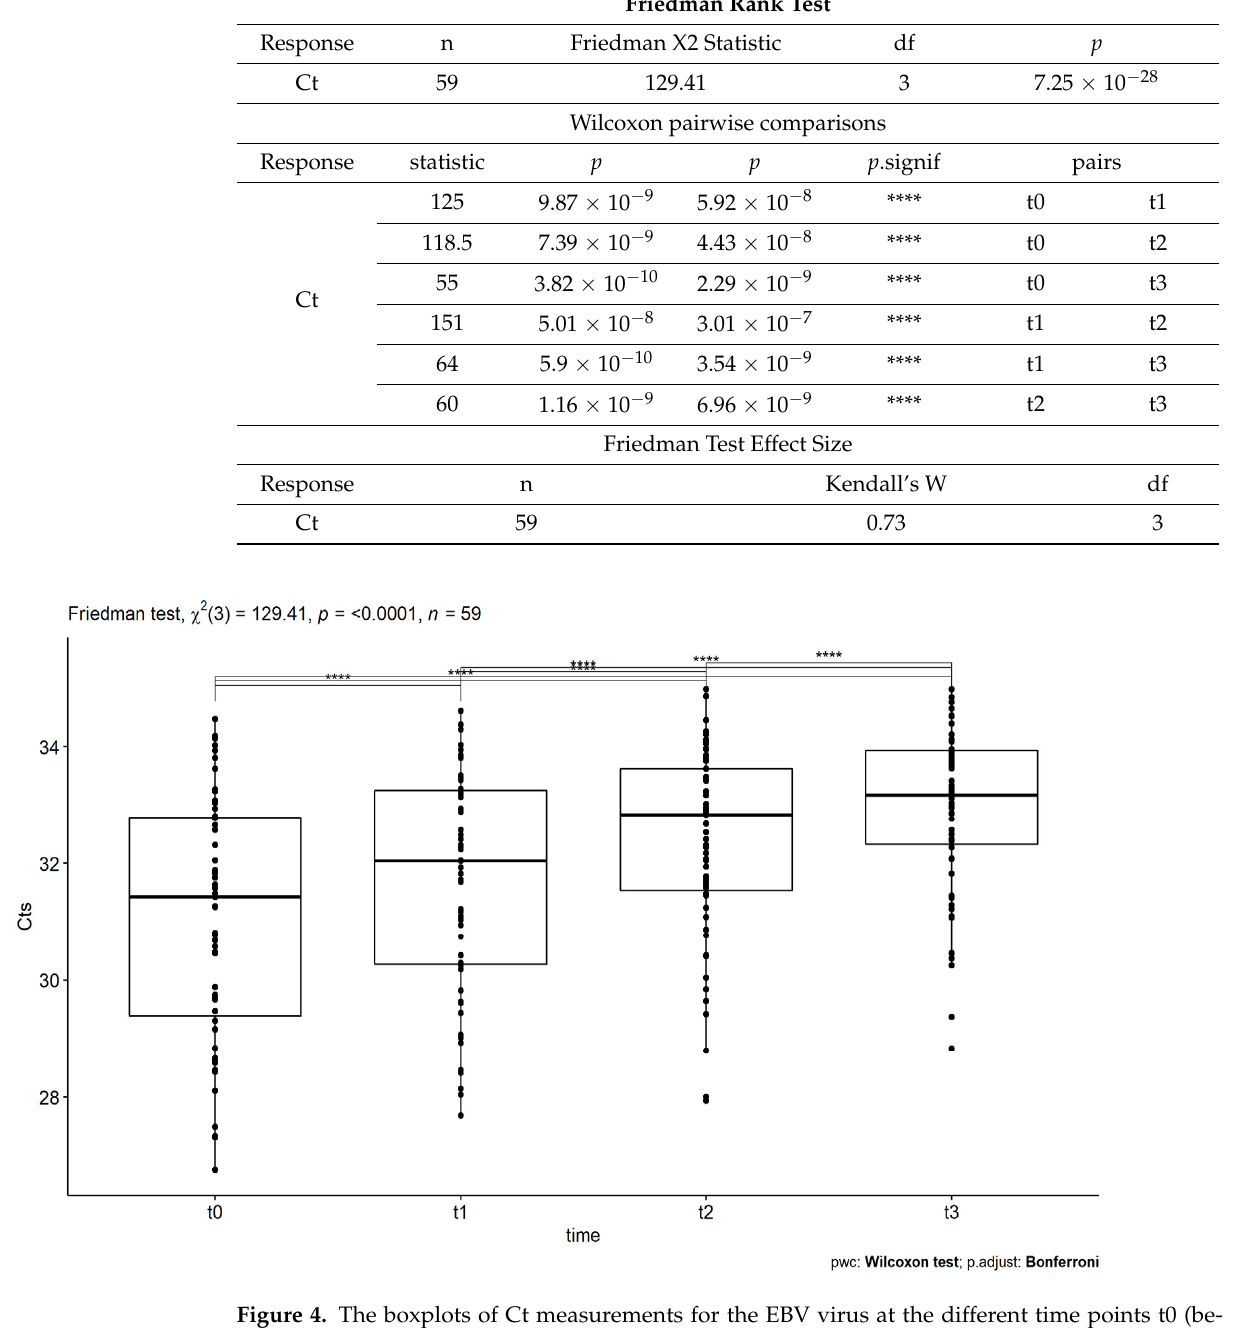
Figure 4. The boxplots of Ct measurements for the EBV virus at the different time points t0 (before the first SOT administration), t1 (after the first SOT treatment administration), t2 (after the second treatment administration), and t3 (after the third treatment administration). The asterisks denote significance codes, namely ‘****’ stands for p -value < 0.0001. All increases in the values are statistically significant.